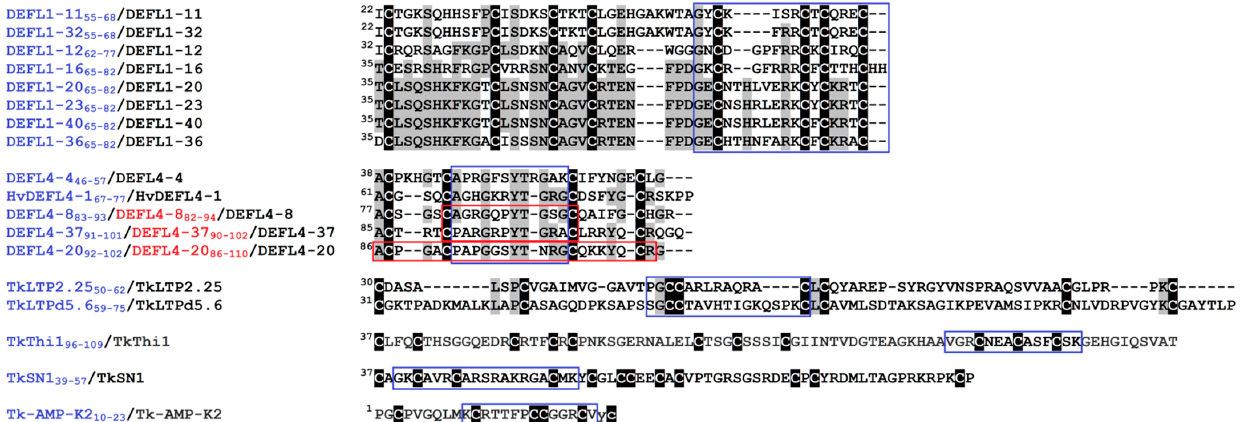
Figure 1. Multiple sequence alignment of the γ -core-containing regions of selected wheat and barley AMPs. Superscript numbers denote their position in the precursor proteins. The names of synthetic peptides and their parent AMPs are shown on the left. The sequences of synthesized peptides are framed (in purple and red). Cysteine residues are shaded black, and identical amino acids are shaded gray.